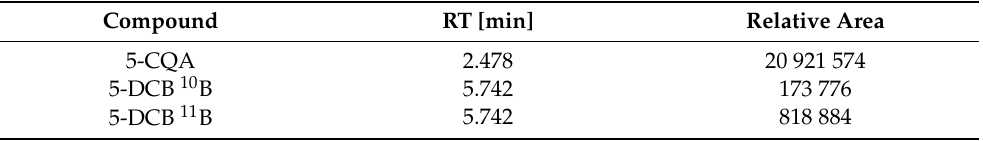
Table 2. RTs and relative areas of the identified compounds.